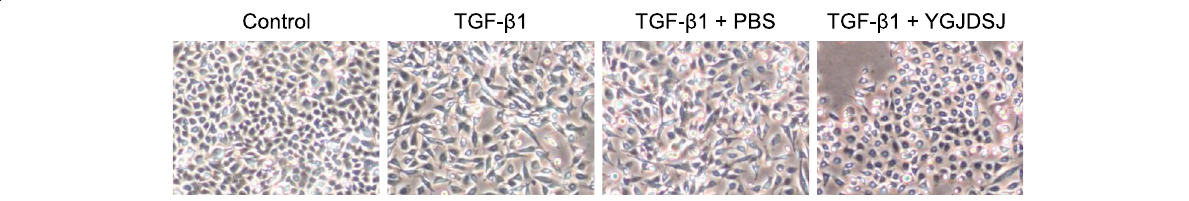
Fig. 1 Effects of YGJDSJ on TGF- β 1-induced morphological changes. Bel-7402 cells were treated with TGF- β 1 and YGJDSJ or PBS for 48 h, and cell morphology was observed under a microscope (× 200)